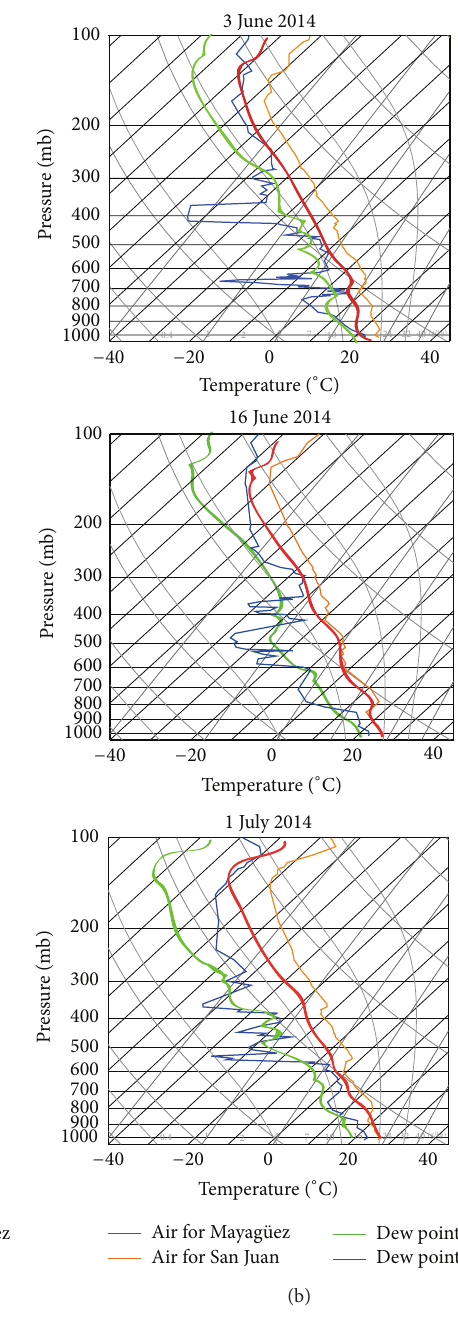
Figure 5: (a) Skew-T plots for heavy SD days over Mayag¨uez. (b) Skew-T plots for 0800 AST (3 and 16 June 2014 and 1 July 2014) launches over Mayag¨uez and San